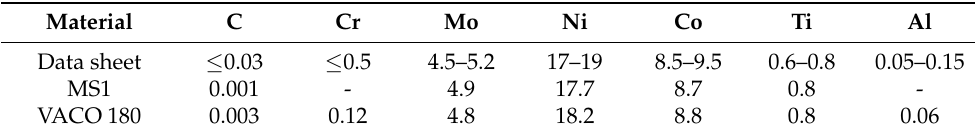
Table 1. Chemical composition of the steels, including the values declared in the datasheet, in